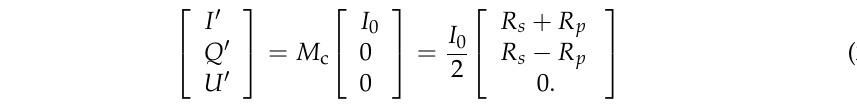
The calculated polarization degree of the UV collimator is shown in Figure